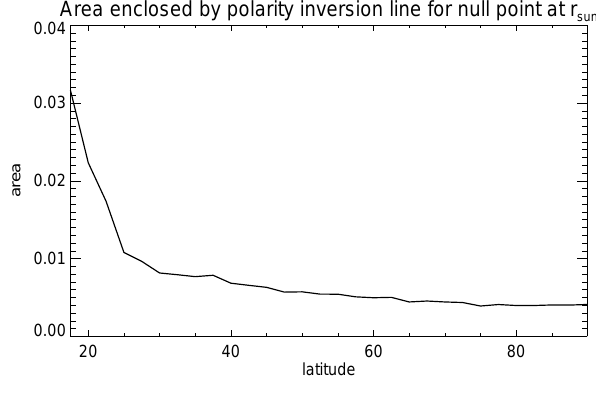
Fig. 4. Magnetic flux enclosed by PIL as a function of solar latitude for a null point at r = r (cid:12) . The plot shows that the amount of opposite polarity flux in the vicinity of a bald patch decreases strongly with latitude. This means that an embedded dipole with a given normal- ized surface magnetic flux of e.g. 0.01 can only give rise to a bald patch at latitudes of less than about 25 ◦ .